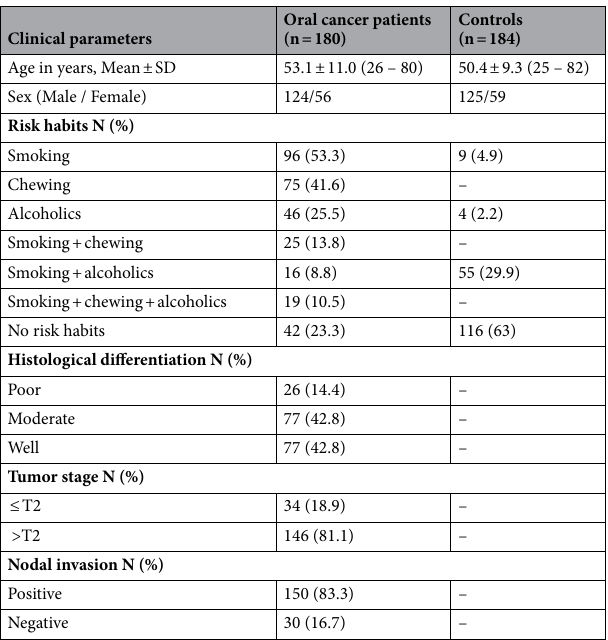
Table 1. Demographic and clinical data of oral cancer patients and healthy